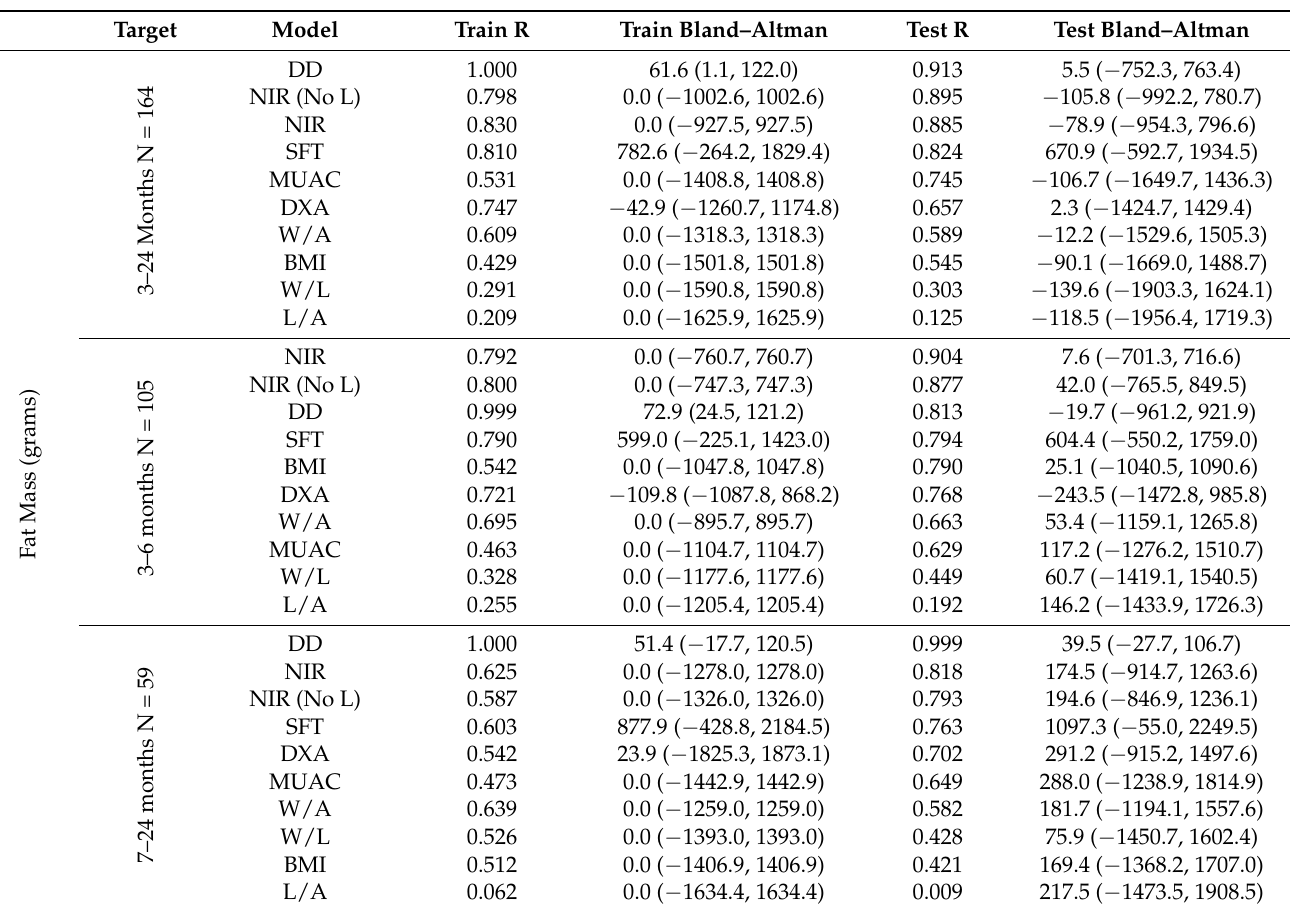
Table 3. Fat mass prediction for each method analysed: Overview of correlation and Bland–Altman agreement. Methods for comparison include body mass index (BMI), sum of skinfold thicknesses (SFT), weight-for-length percentile (W/L), length-for-age percentile (L/A), weight-for-age percentile (W/A), mid upper arm circumference (MUAC), Deuterium Dilution (DD), and dual-energy X-ray absorptiometry (DXA). The training set fit, including correlation (R) and Bland– Altman agreement, is shown. Independent Testing set R and agreement are also included. Bland–Altman agreement is displayed as mean difference (95% confidence intervals). Training was performed with the 4-Compartment model as the target and was subsequently evaluated with the 4-Compartment model. The table is arranged from best to worst test R for each age